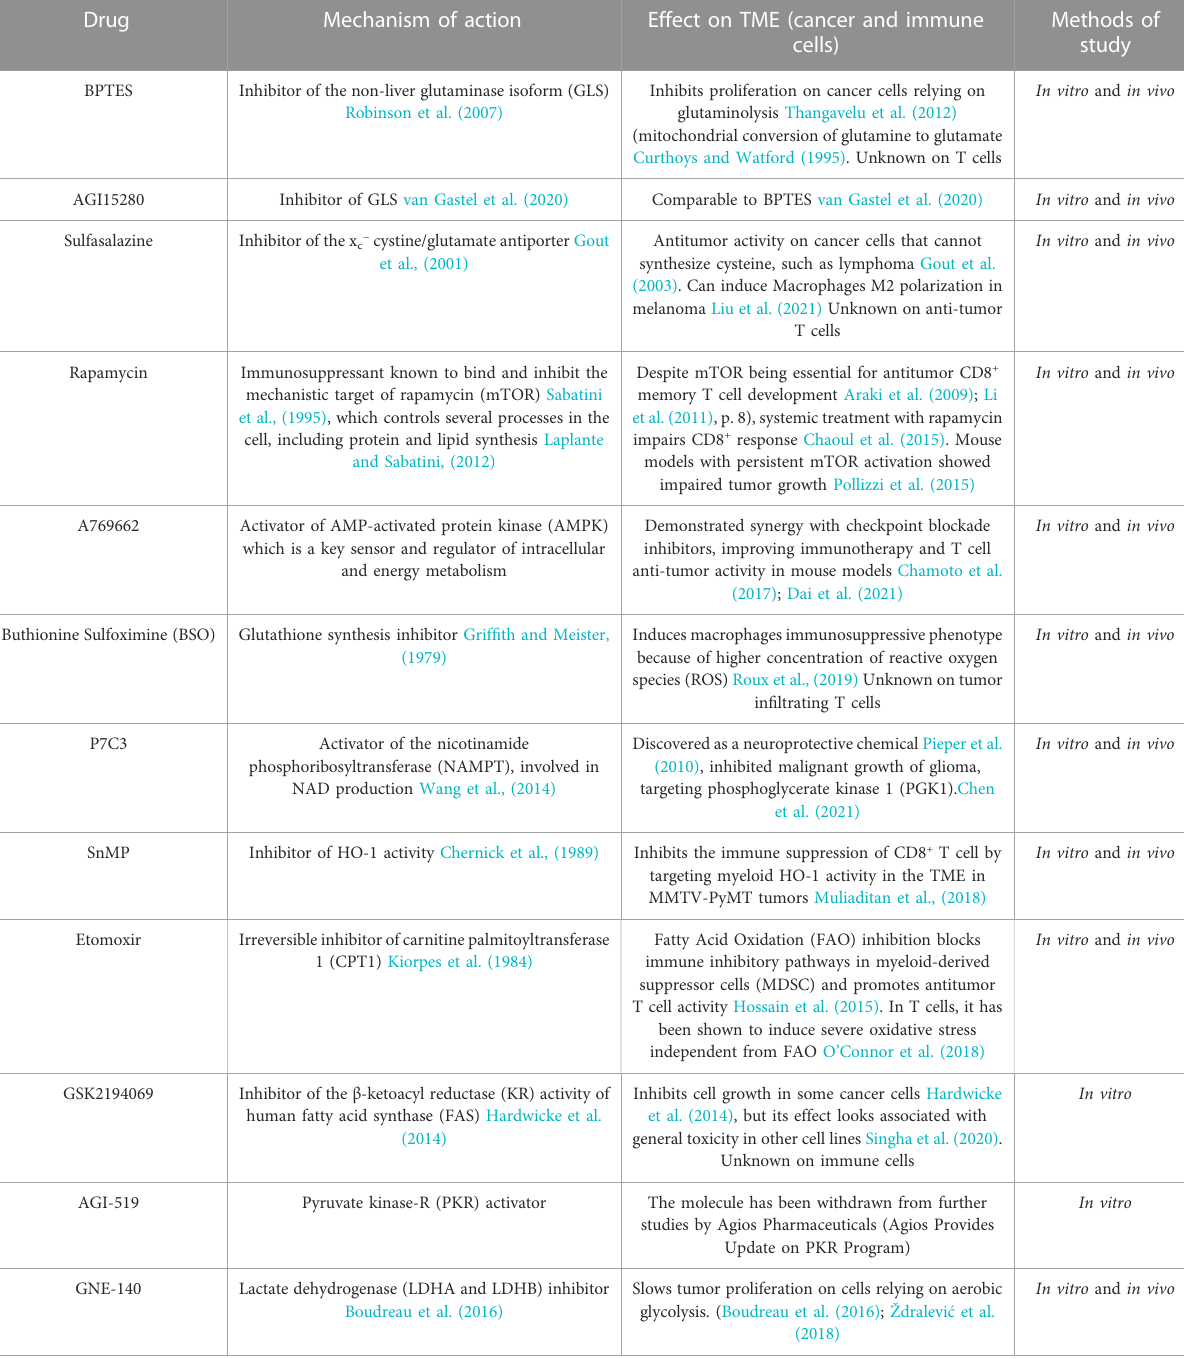
TABLE 2 Drugs targeting cell metabolism delivered with the bio microdevice in the MMTV-PyMT mice tumors. Drug Mechanism of